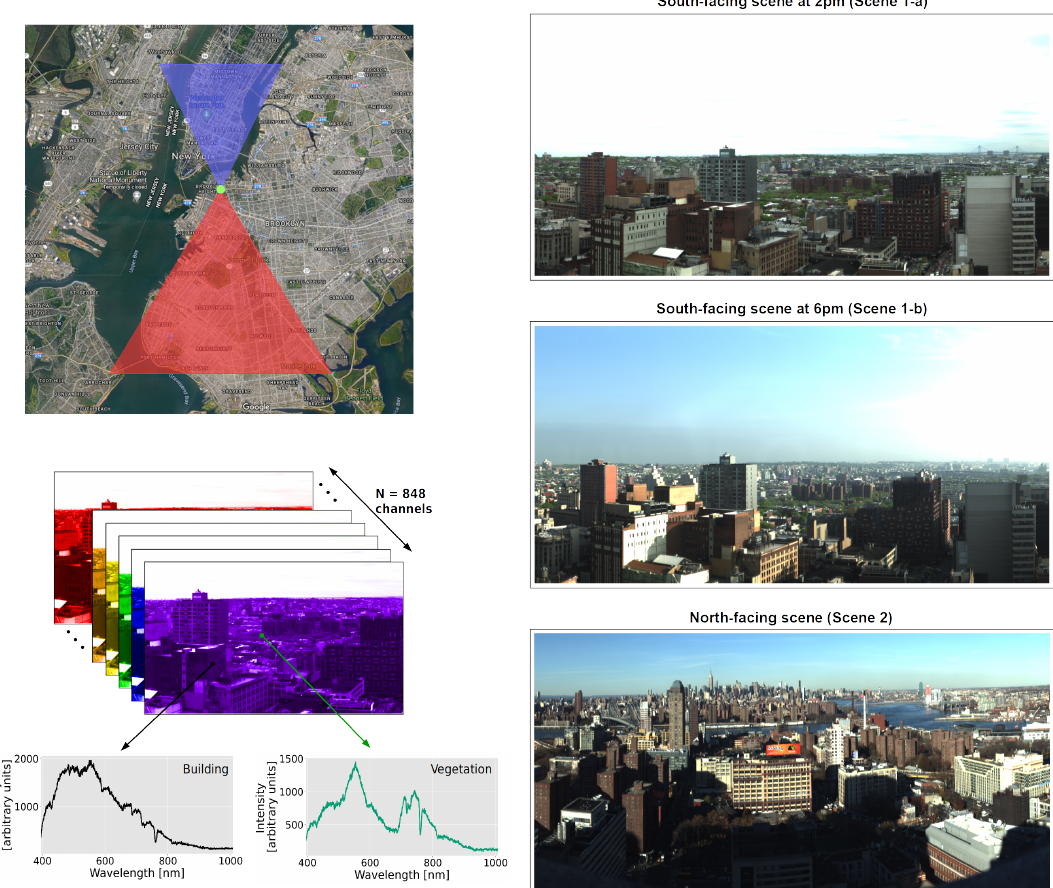
Figure 1. ( top left ) Map of New York City showing the location of the Urban Observatory (green dot), coverage of the South-facing Scenes (red triangle) and North-facing Scene (blue triangle). ( bottom left ) A graphic representation of our hyperspectral datacube, where each spatial pixel has 848 wavelength channels that can be used to capture a full spectrum as seen in the two examples provided. ( right ) RGB (610 nm, 540 nm, and 475 nm) representations of the scenes imaged by the Urban Observatory’s hyperspectral imaging systems. Scenes 1-a and 1-b ( top and middle ) are south-facing pointings covering Downtown and North Brooklyn at 2pm and 6pm respectively. Scene 2 ( bottom ) is a north-facing pointing acquired with a different instrument covering northern Brooklyn and